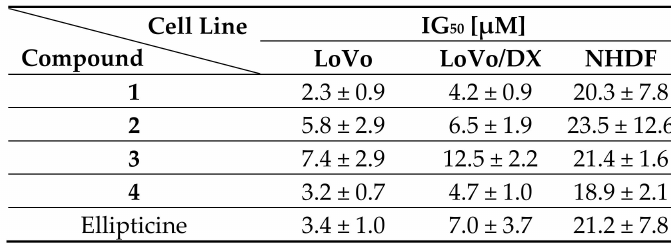
Table 2. Mitotic index evaluation—IG 50 values for tested compounds in various cell lines.